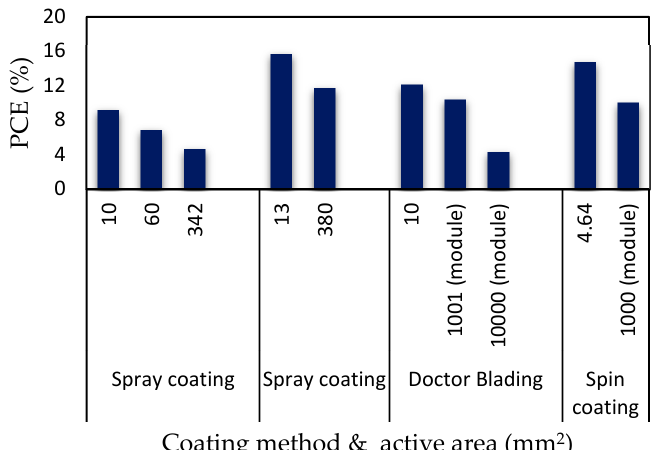
Figure 1. Degradation in the PCE of the PSCs made by various deposition techniques after enlarging the active area of individual cells, or by fabricating modules through connecting several small-area cells in series (data were taken from Refs. [7,12–14]). The precursor solutions associated with the mentioned coating processes are MAPbI 3 , MA(I x Br 1 − x ) 3 , PbI 2 , and MAPbI 3 , respectivley, and from left to right. In the doctor blading case, the perovskite layer was obtained by dip coating of the blade-coated PbI 2 film in the methylamonium iodide solution [12].